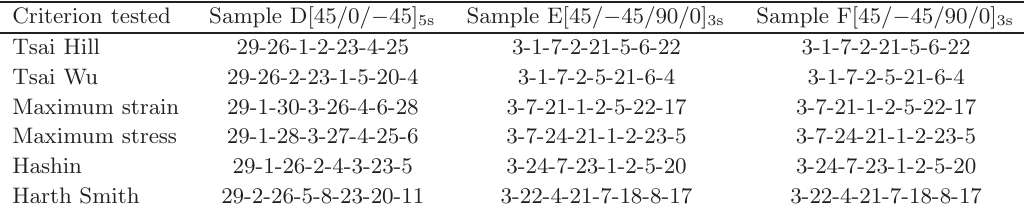
Table 4. Successive failures results of laminates (D, E, F) with the total discount method.